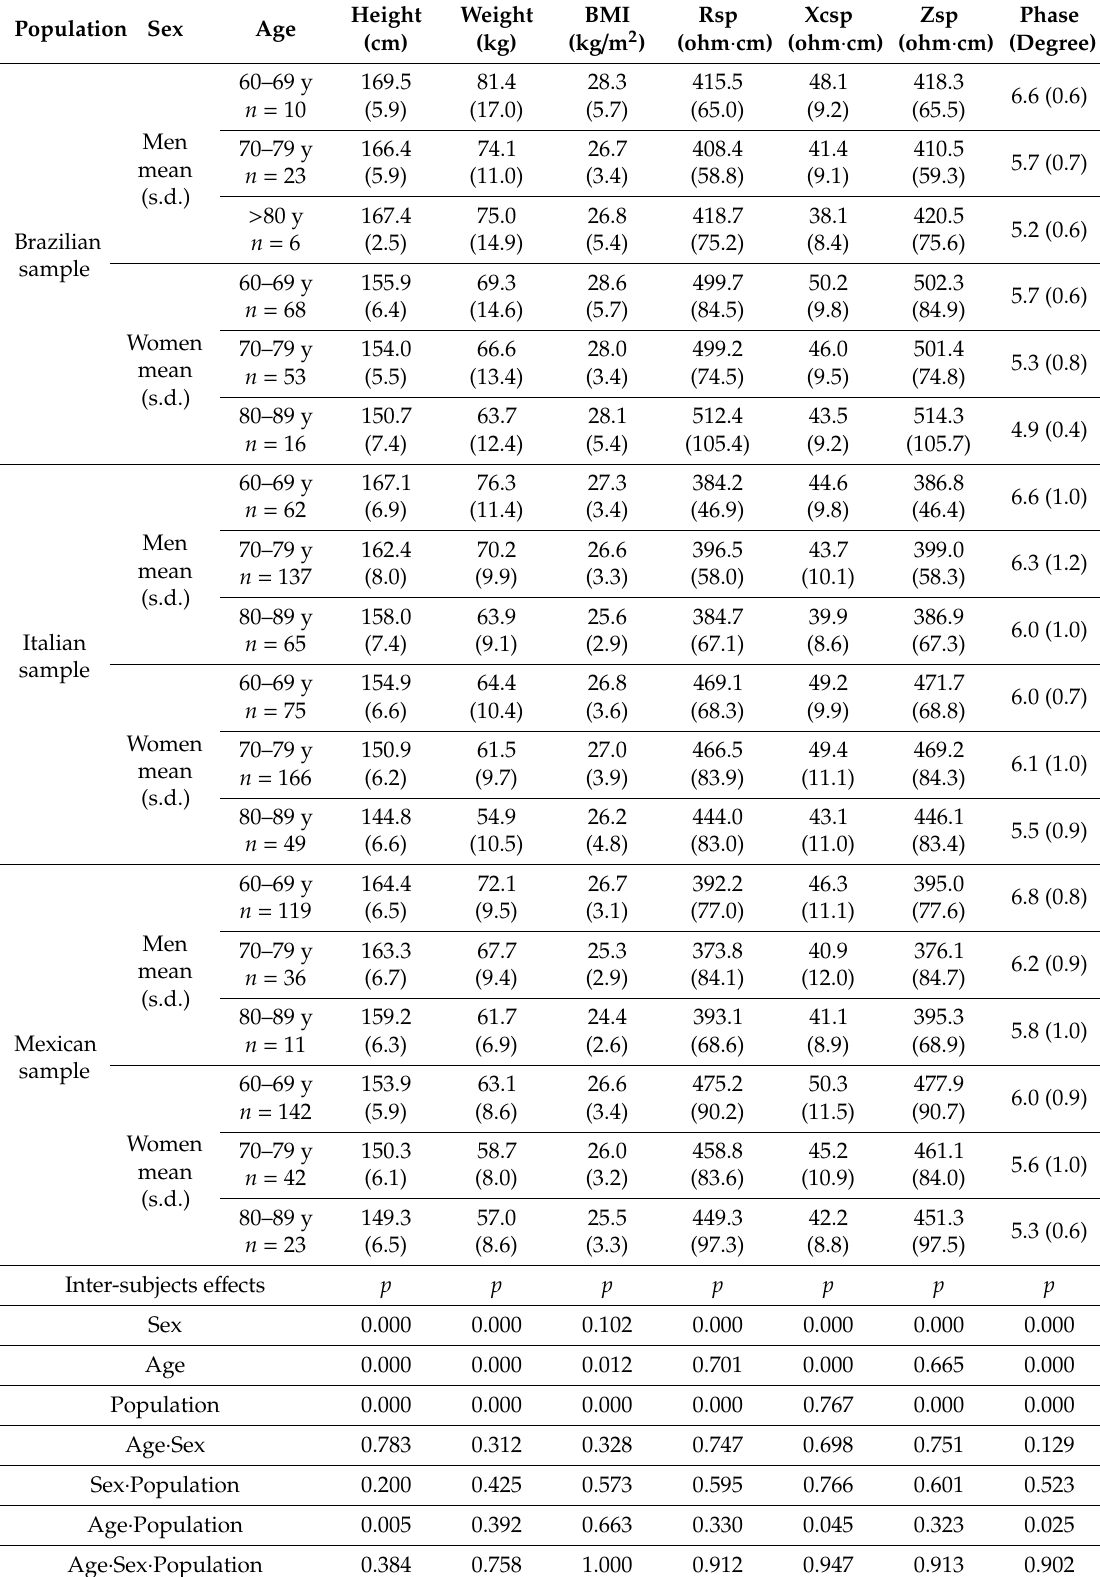
Table 1. Descriptive statistics and two-way ANOVA results for the comparison among sex, age, population